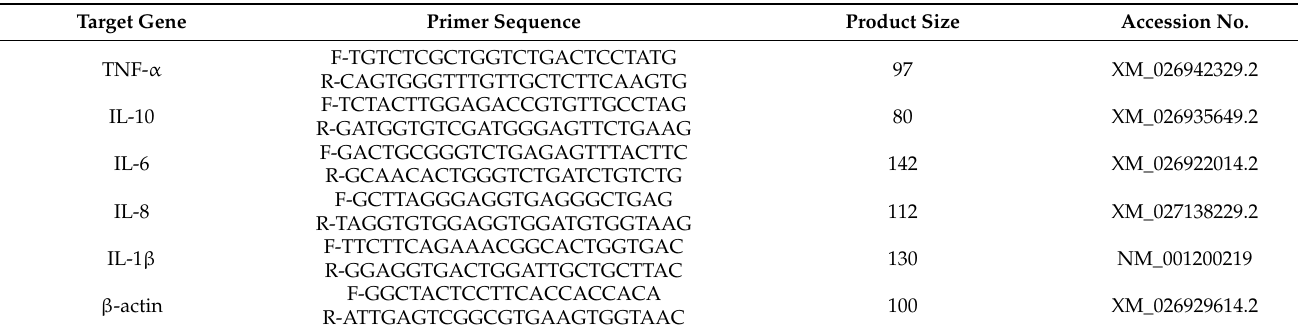
Table 3. The expression level or target genes were calculated by the 2 − and normalized with the expression level of β -actin in the H0 group. Table 3. Primers pair sequences used for real-time